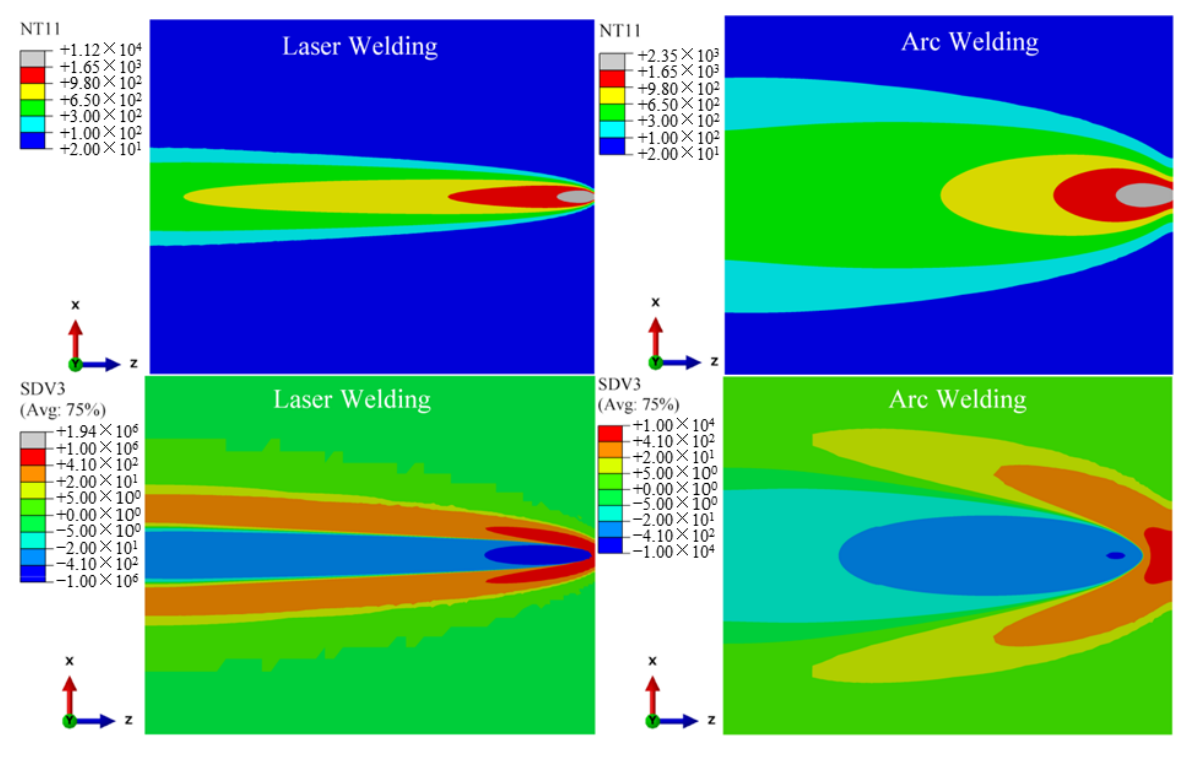
Figure 16. 100 mm from starting position, changes of current temperature NT11( °C ) and cool- ing/heating rate SDV3( °C /s) during welding.